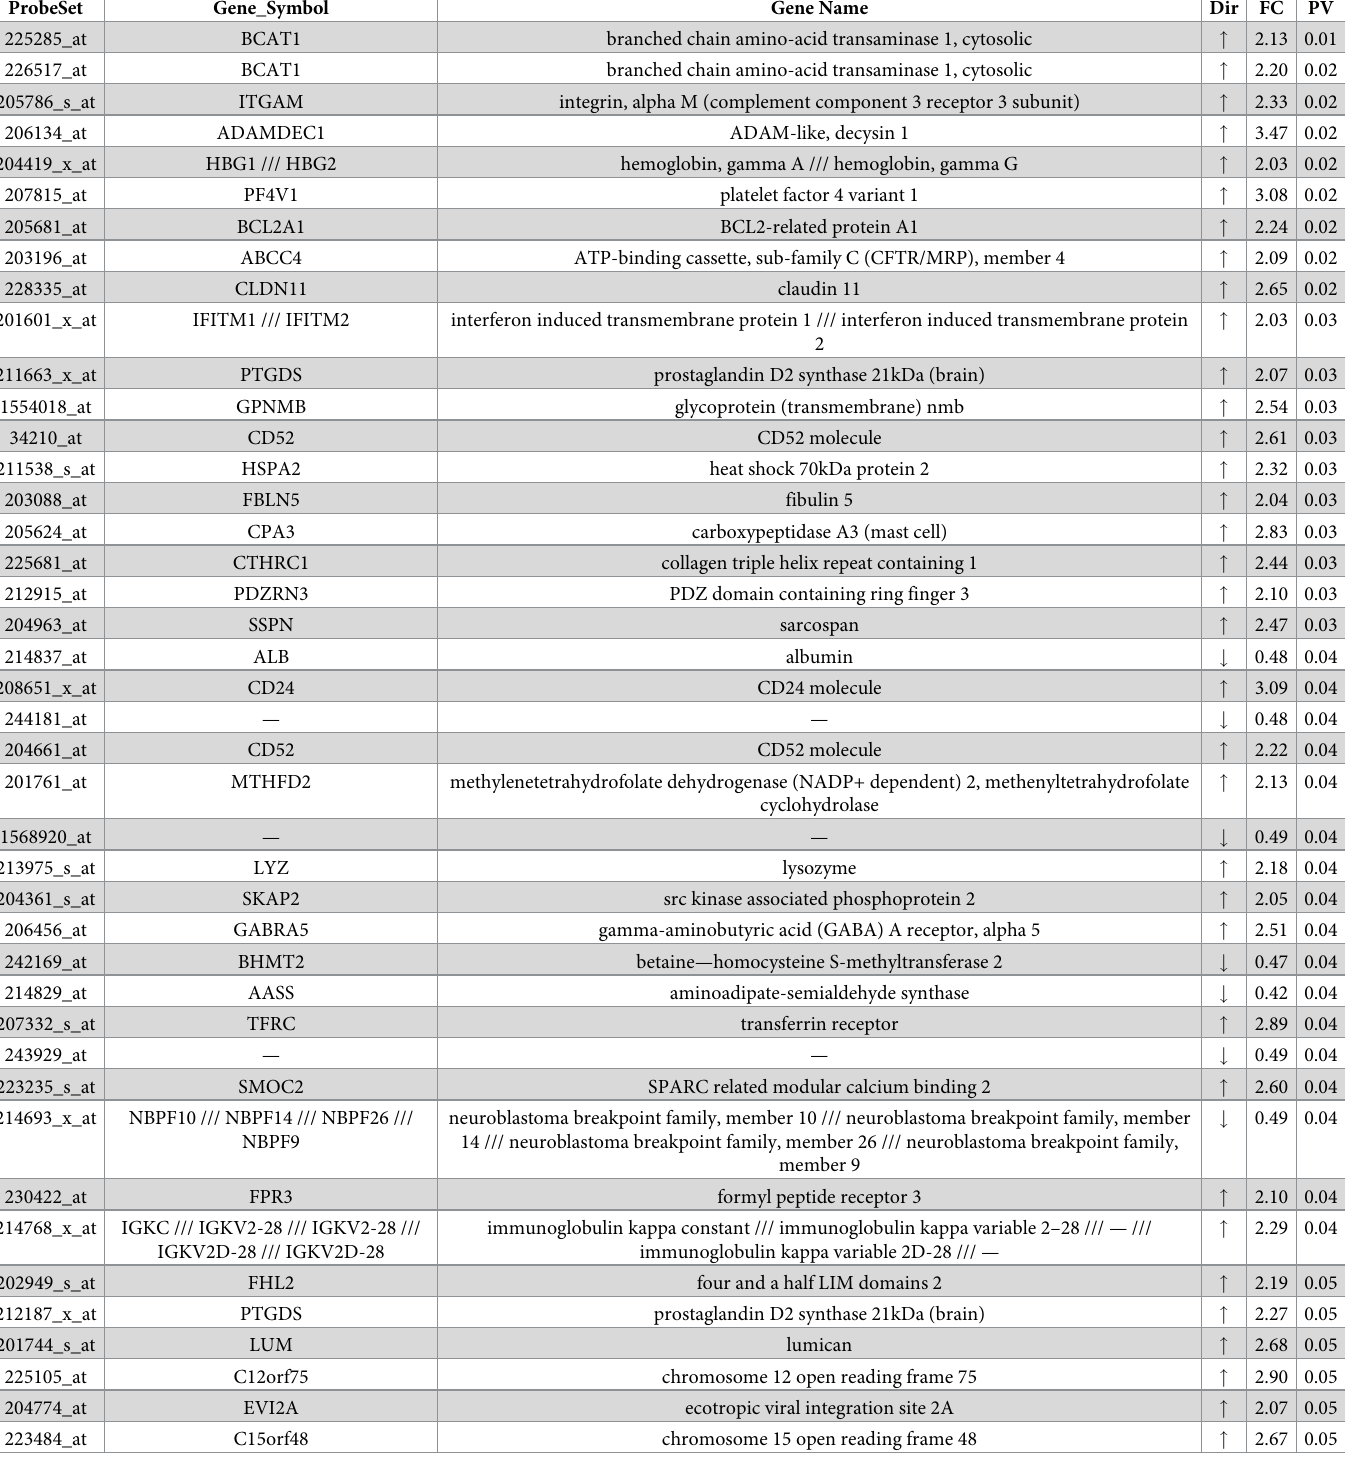
Table 3. Differentially expressed genes associated with clinical outcomes. All probes have a false discovery rate of 0.65.